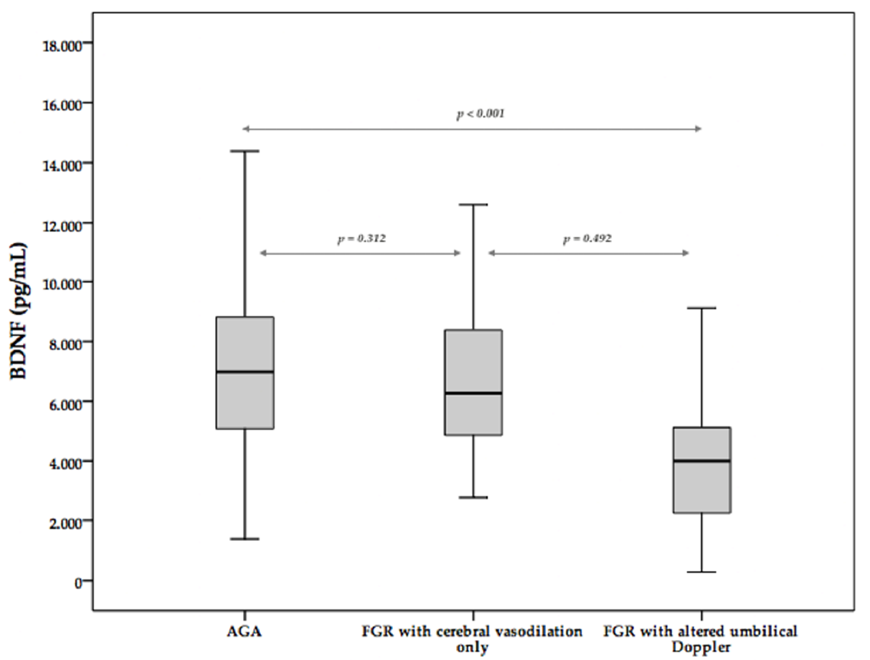
Figure 2. BDNF Box plot with subgroup of fetuses with brain sparing. p adjusted for gestational age